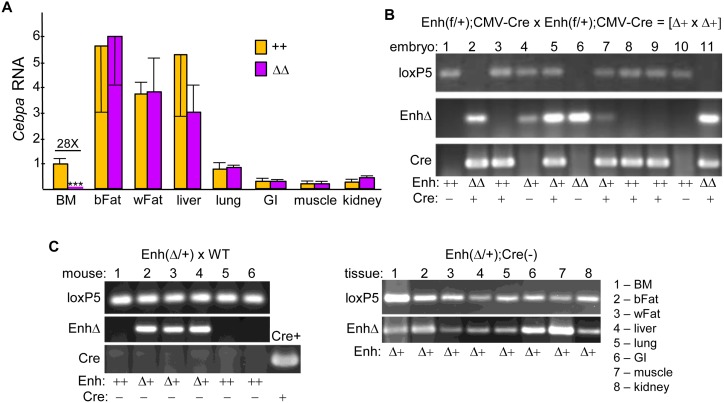
Effect of Germline Enhancer Deletion on Cebpa Expression in Non-Hematopoietic Tissues.A) Total RNAs from marrow mononuclear cells, brown fat (bFat), white fat (wFat), liver, lung, small intestine (GI), skeletal muscle, or kidney from wild-type (++) and Enh(f/f);CMV-Cre (ΔΔ) mice were analyzed similarly for relative Cebpa expression (n = 3). B) Total embryo DNA from a litter obtained at E16.5 from a cross between Enh(f/+);CMV-Cre (Δ+) mice was subjected to PCR using the loxP5, EnhΔ, and Cre primer pairs, followed by agarose gel electrophoresis and ethidium bromide staining. Enhancer and Cre genotypes are indicated. C) Tail DNA from a litter of 4 wk pups obtained from a cross between a WT and Δ+ mouse, both lacking CMV-Cre, was analyzed similarly (left). DNA from a mouse harboring Mx1-Cre served as a positive control for the Cre PCR (Cre+). DNAs from adult tissues of one of the Δ+ pups were also analyzed using loxP5 and EnhΔ5 PCR (right). * - p<0.05, ** - p<0.01, *** - p<0.001.